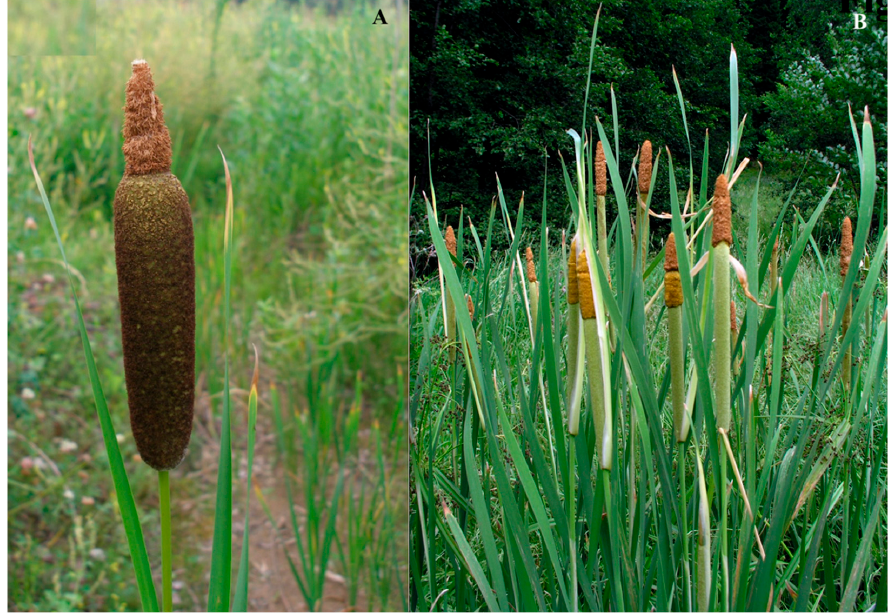
Figure 2. Typha lepechinii sp. nov.: male and female inflorescences ( A ) and general aspect ( B ). A. Russia, Udmurt Republic, City of Izhevsk, vicinity of the botanical garden of Udmurt State University, drainage channel; 56°55 ′ N, 53°15 ′ E; 25 July 2010 ( locus classicus ). B. Russia, Udmurt Republic, Alnashsky district, five km south of the village Muvazhi; ~56°01 ′ N, 52 ˚ 42 ′ E; shallow water of a small oxbow on river Golyushurminka. Photos: V. I. Kapitonov, modified from Kapitonova et al. [10] with permission from the American Journal of Plant Science .